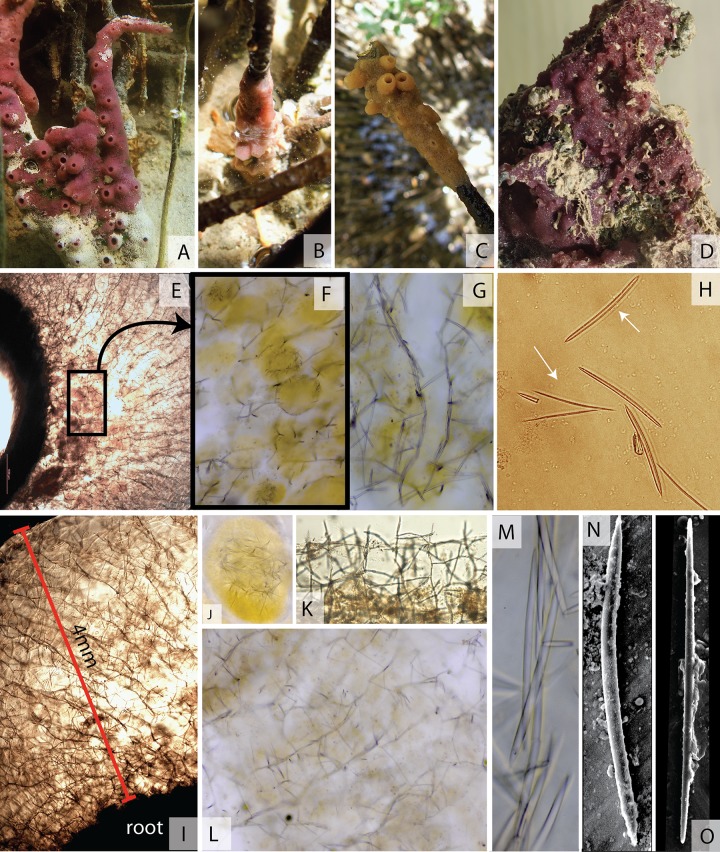
Chalinula qatari sp. nov., morphology, skeleton and
spiculation.Morphology: Living specimens (A) attached to mangrove pneumatophores in
the riparian zone, (B, C) in the intertidal zone, (D) under limestone in
the channels between the mangroves. Skeleton and spicules: (E)
choanosomal skeleton; (F) embryos; (G) ascending spicule tracts; (H)
oxeas, showing immature thinner forms; (I) choanosomal skeleton showing
thickness of encrustation on a mangrove root; (J) embryo; (K) Cross
section of ectosome (specialised ectosomal skeleton absent); (L)
choanosomal skeleton showing length of secondary spicule tracts; (M)
close up of ascending primary spicule tract. Electronic microscopy of
(N) large, thick oxea (O) thinner oxea.